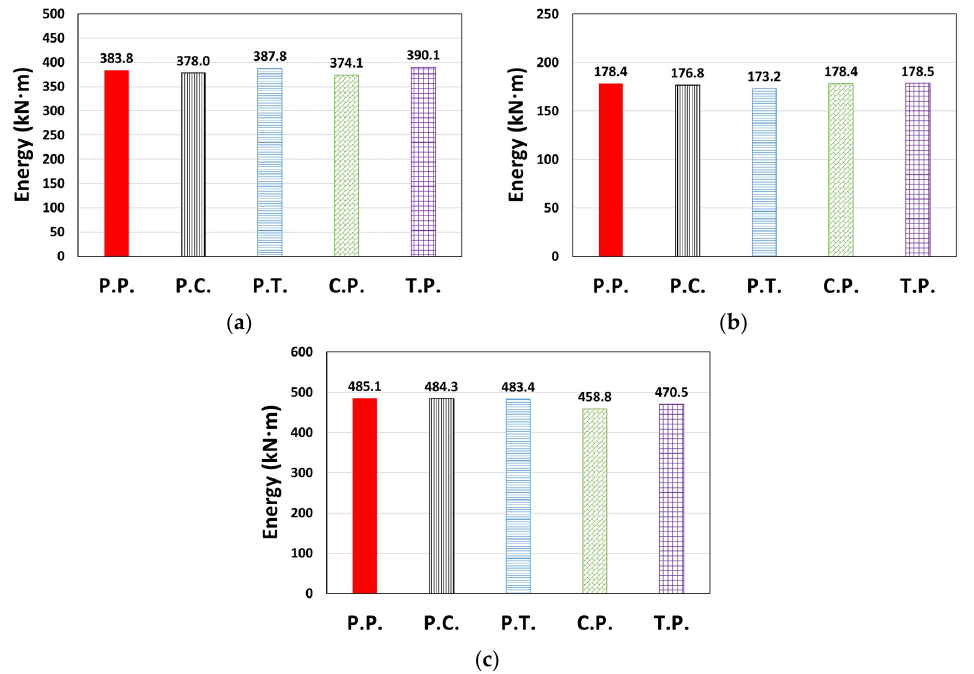
Figure 8. Total dissipated energy ( E t ): ( a ) Type 1 (El Centro, X-dir.), ( b ) Type 2 (El Centro, Y-dir.), and ( c ) Type 3 (El Centro, Y-dir.).